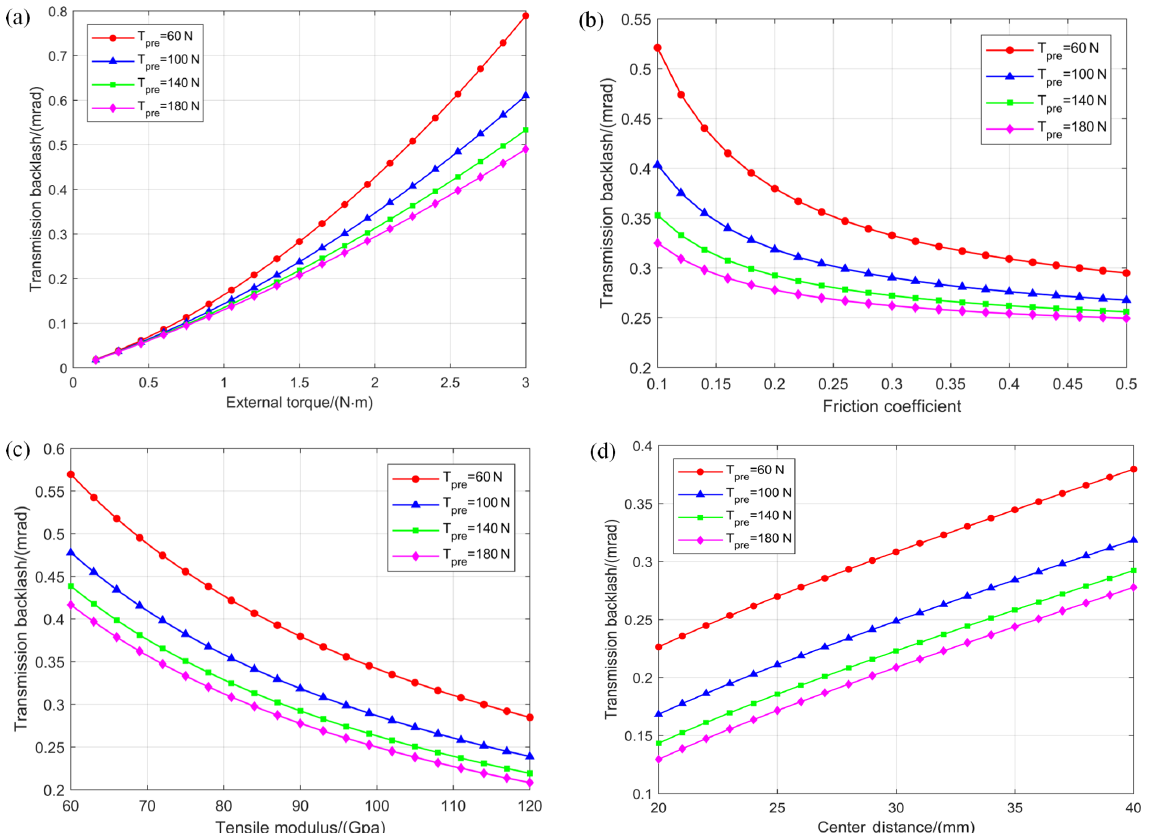
Figure 5. Parametric sensitivity analysis for transmission backlash: (a) the effect of preload and external torque; (b) the effect of preload and friction coefficient; (c) the effect of preload and tensile modulus; (d) the effect of preload and centre